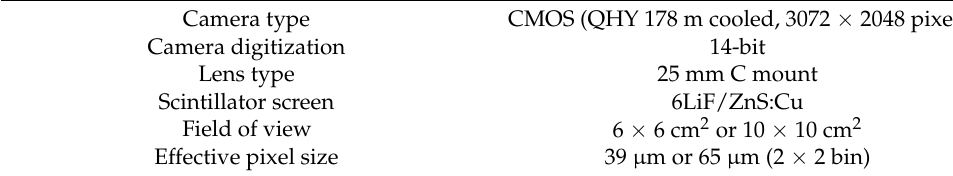
Table 2. Main parameters of the NIFFLER neutron imaging